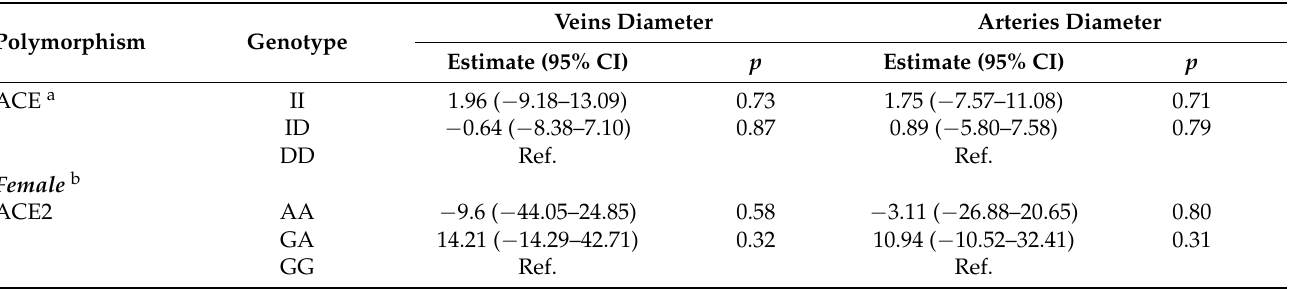
Table 4. Association between the genotypes for ACE I/D, ACE2 rs2285666, and AGTR2 rs1403543 and retinal vessel